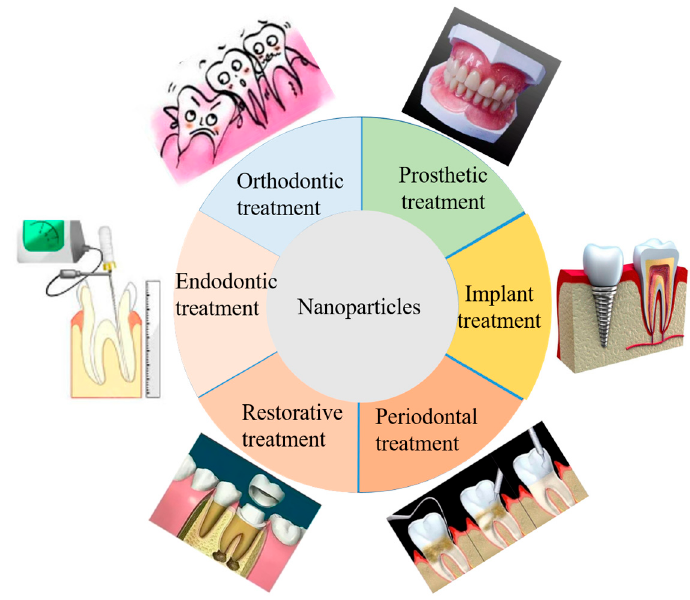
Figure 2. The application of nanoparticles in dentistry.